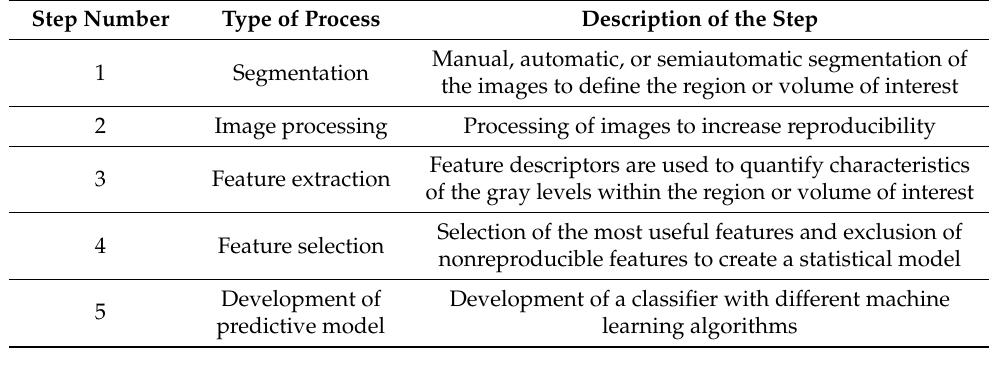
Table 1. Summary of main steps for radiomics analysis.